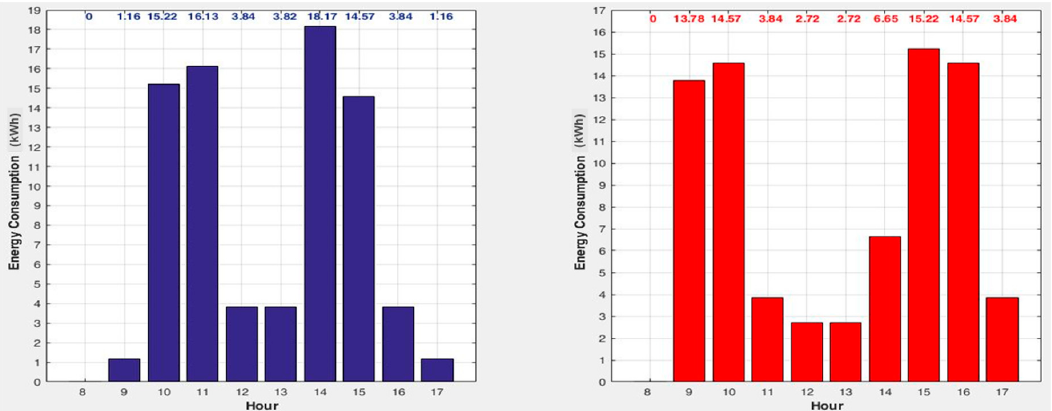
Figure 16. The real (blue) and optimal (red) hourly energy consumptions.